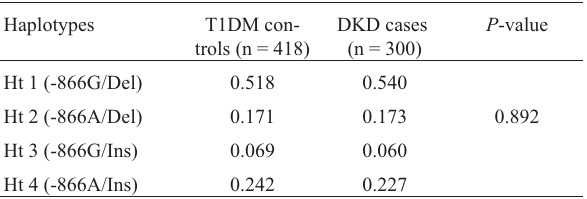
Table 3 - Haplotypes of the UCP2 polymorphisms in T1DM patients with and without DKD.